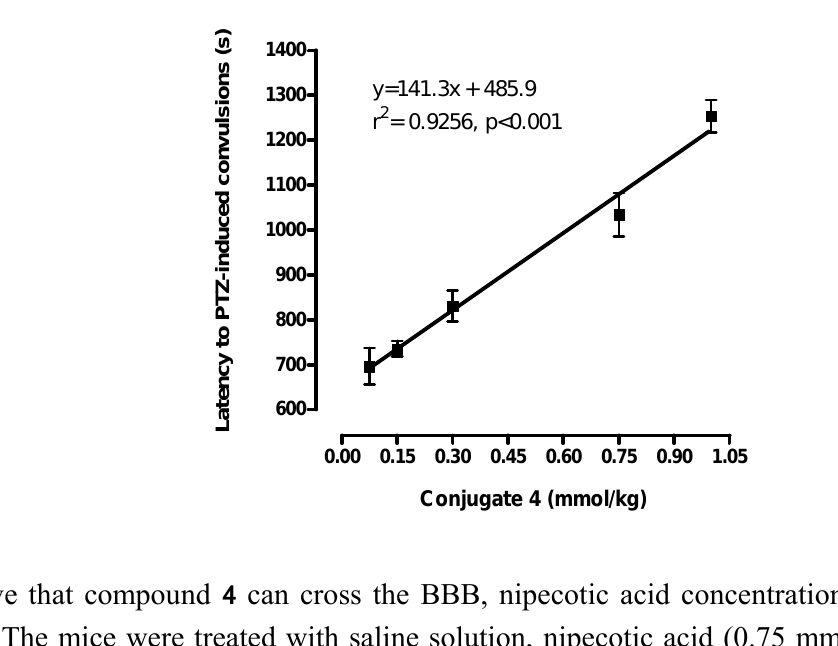
Figure 1. Dose-response effect of conjugate 4 (0.75 mmol/kg ip) on pentylenetetrazole (PTZ)-induced convulsions in mice. Each point represents the mean ± SEM of 6-7